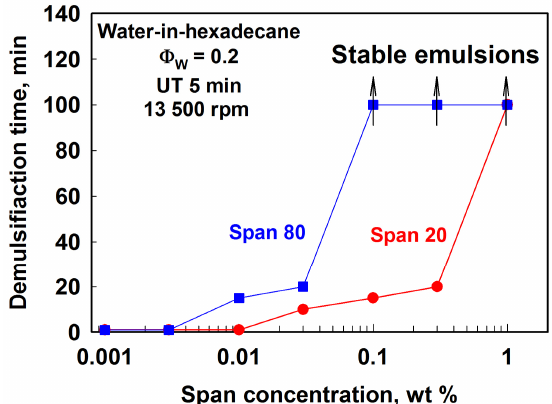
Figure 2. Demulsification time as a function of the weight concentration of the surfactants Span 20 and Span 80 for 20 vol % emulsions of water-in-hexadecane. The emulsification procedure was performed with Ultra Turrax rotor-stator homogenizer for 5 min at 13,500